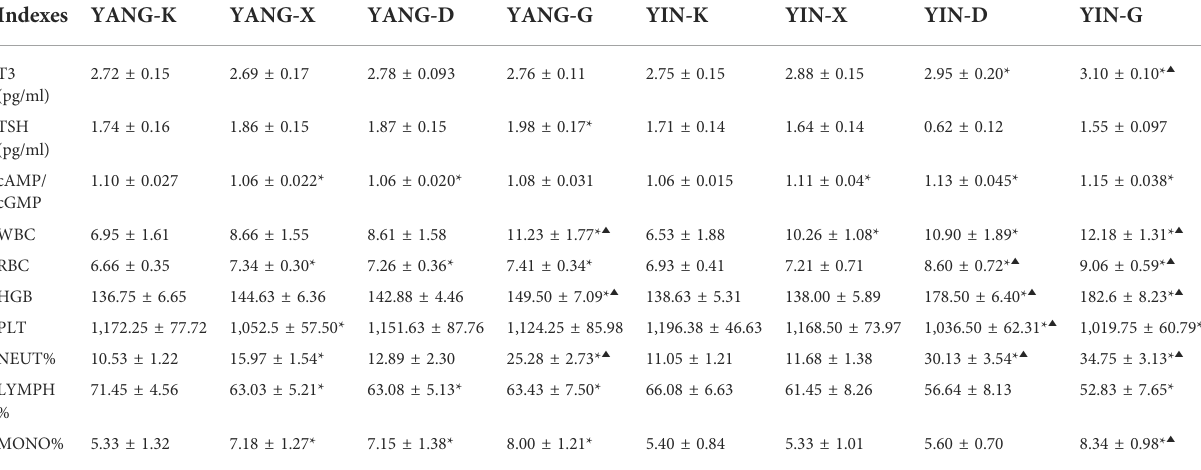
TABLE 7 Results of T3, TSH, cAMP, cGMP, and routine blood test of rats ( n = 8, ‾ x ± s ). Indexes